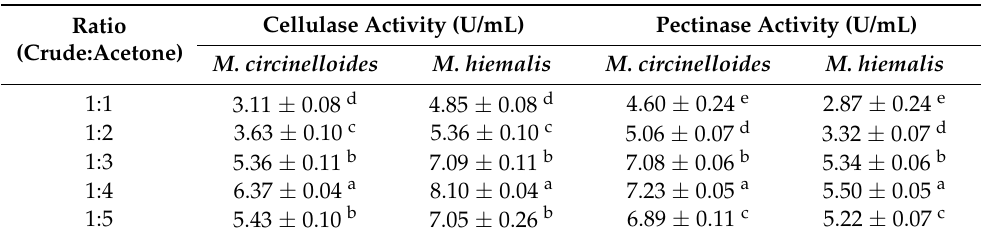
Table 8. Precipitation of cellulase and pectinase produced by M. circinelloides and M. hiemalis using different concentrations of acetone.